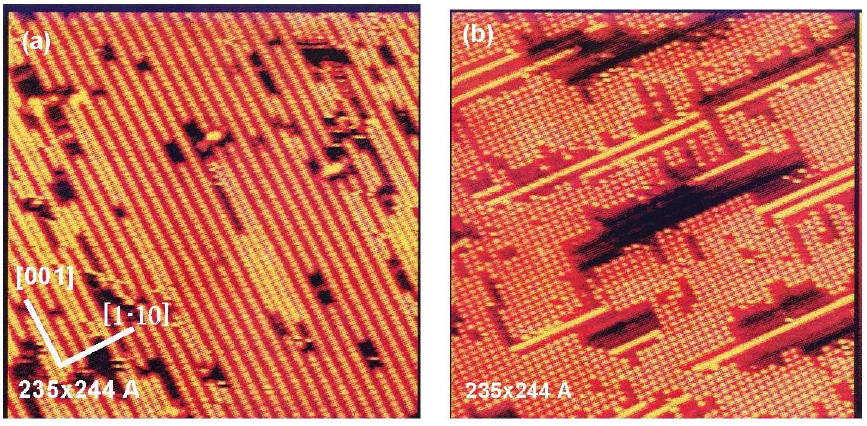
Figure 8. STM image indicating compression of (3 × 1) (-Ni-O-) phase by the adsorption of H on the Ni(110) surface at room temperature; ( a ) A p(3 × 1) Ni(110)-O phase 2 (  = 0.31 mL) on a Ni(110)-O; ( b ) The (3 × 1) (-Ni-O-) phase is compressed to (2 × 1) o (-Ni-O-) phase by the growth of (-Ni-H-) strings along the [001] direction